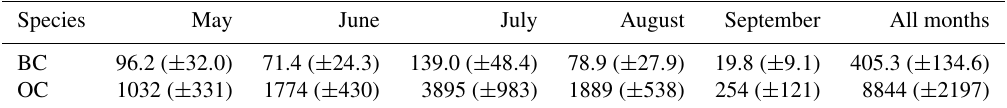
Table 3. Optimal estimates of the BC and OC mass (in Gg) emitted from fires in the study region for individual months of 2012 and for the whole period considered (1 May–30 September). The numbers given in brackets are confidence intervals reported in terms of the 90th percentile.